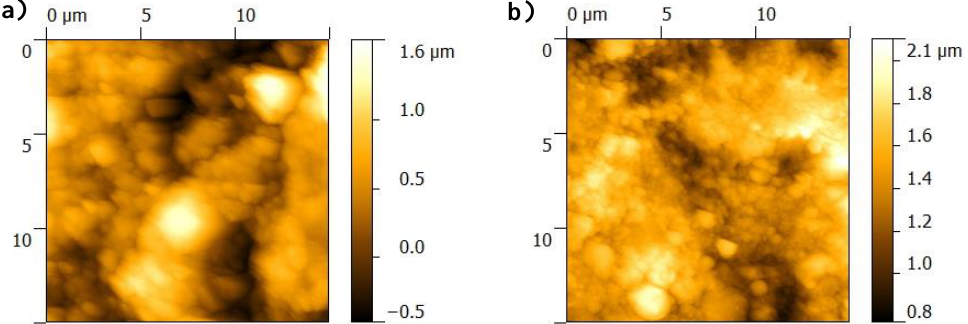
Figure 6. SEM images of ( a ) BGN / PMMA / Ti and ( b ) BGN / PMMA / SS thin films after 28 days of immersion in SBF, at di ff erent magnifications